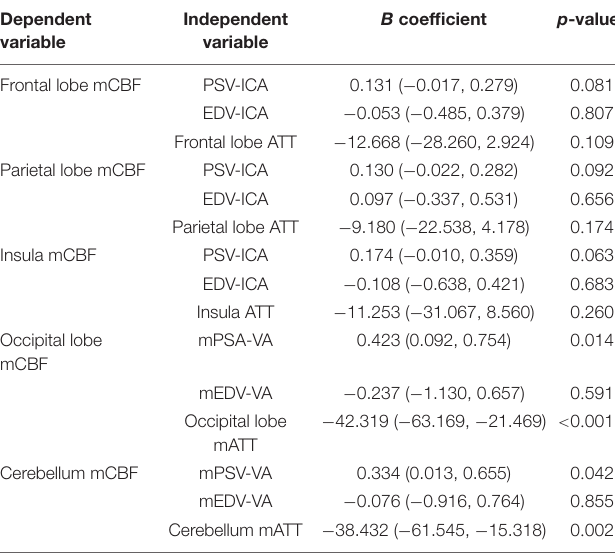
TABLE 2 | Comparison of the blood flow velocity of the extracranial internal carotid and vertebral arteries between the study and control groups.